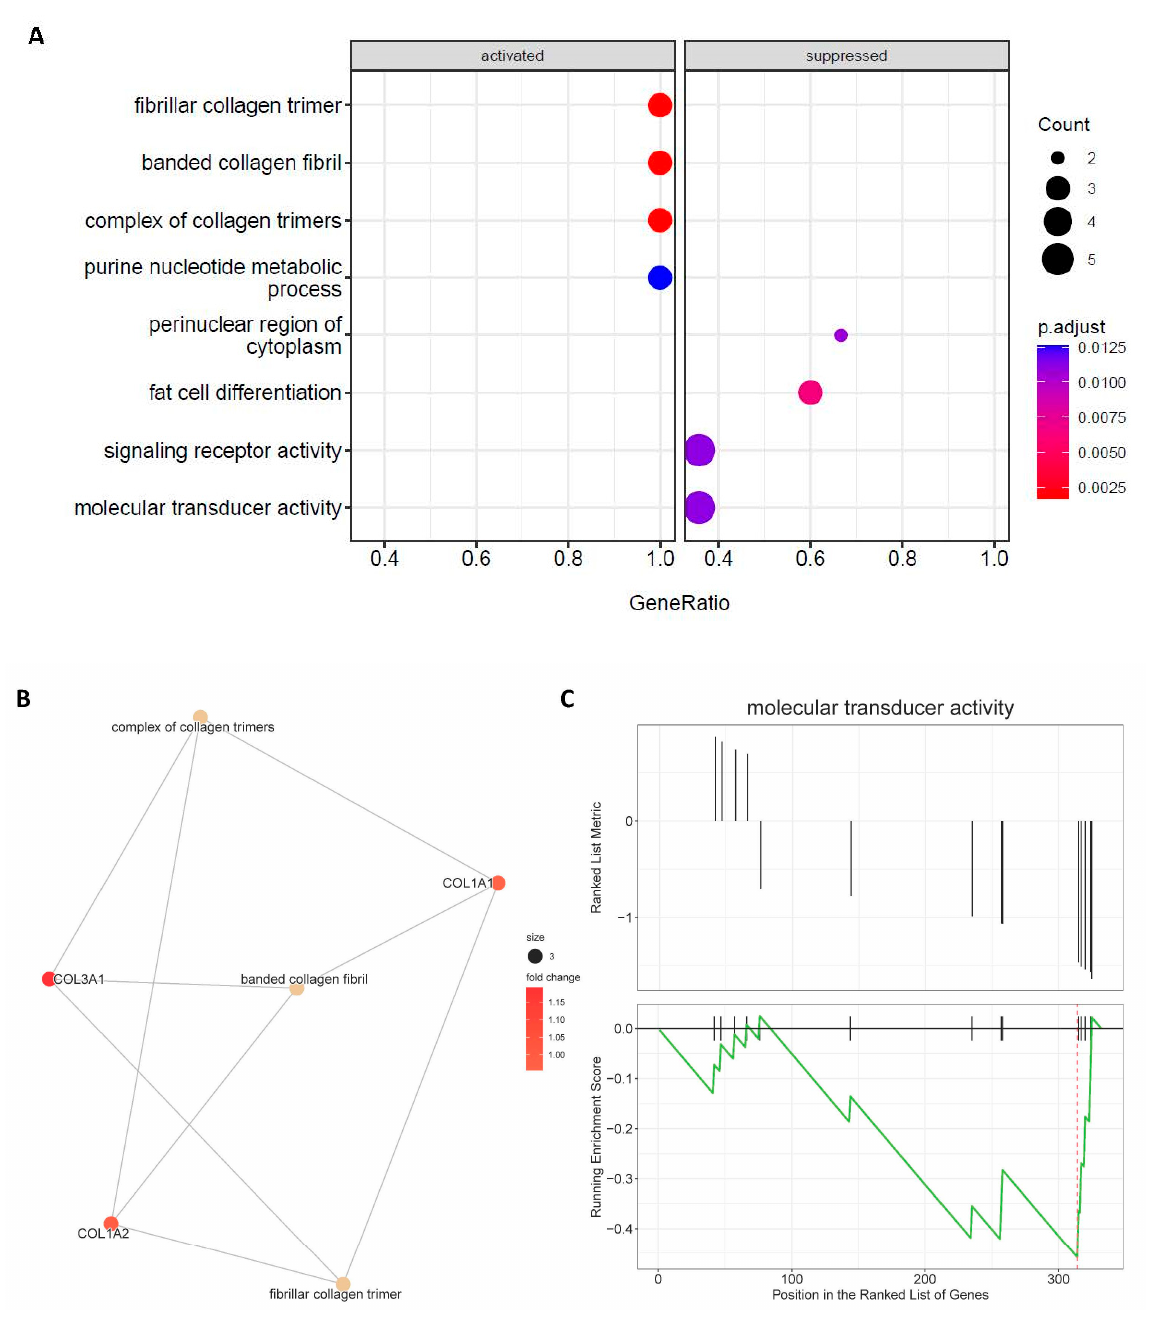
Figure 3. Functional enrichment analysis of ECs and EC-specific expression change of DMD mut and WT muscles. ( A ) Dot plot representing the top four gene ontology (GO) with the largest gene ratios in order of gene ratio. The color gradient of dots represents the adjusted p values, while the size represents the number of genes in the significant DEG list associated with the GO term. ( B ) The cnetplot depicts the linkages of genes and GO terms as a network that is helpful to see which genes are involved in enriched pathways. ( C ) GSEA plot of the running enrichment score (green line) for a gene set as the analysis walks down the ranked gene list, including the location of the maximum enrichment score (the red line). The black lines in the running enrichment score show where the members of the gene set appear in the ranked list of genes, indicating the leading edge